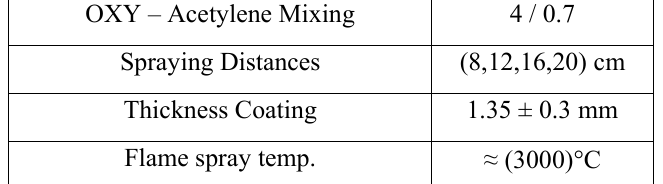
Table 1: The thermal spraying parameters by flame for preparing the cermet compound (Ni-Al+Al O 2 3